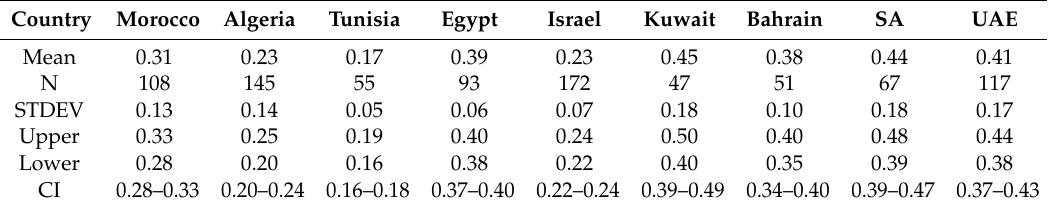
Table 2. Detailed information of aerosol optical depth (AOD) in Figure 9.